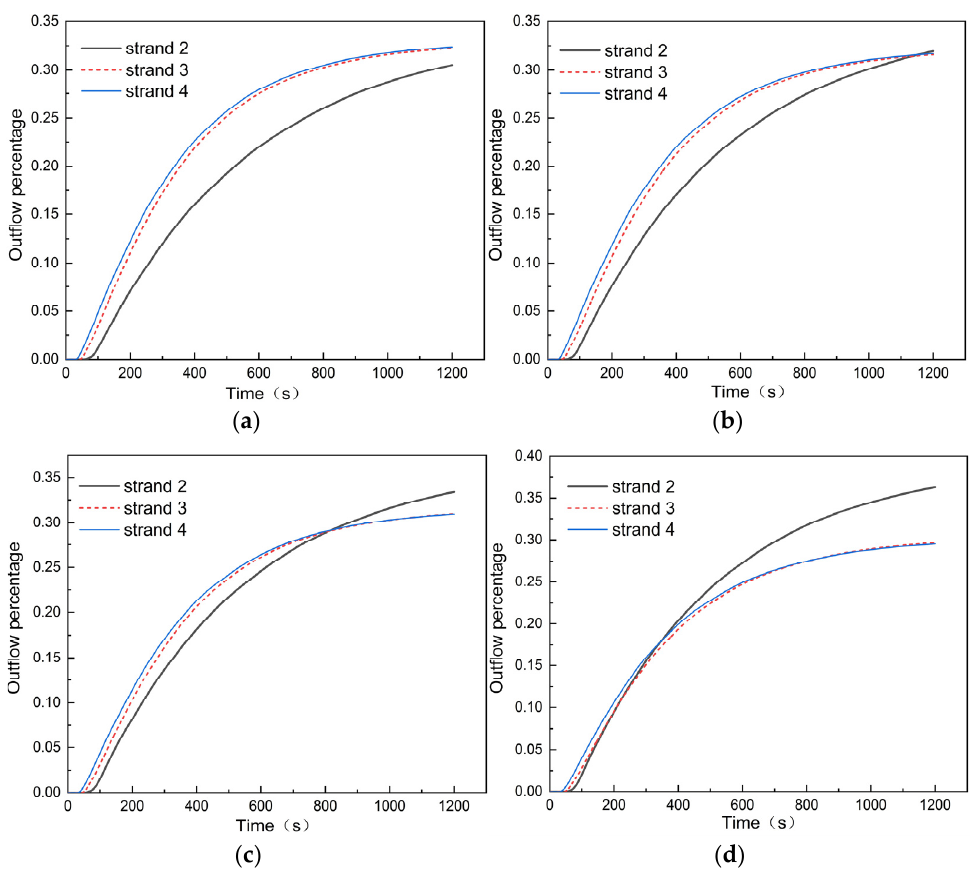
Figure 22. Outflow percentage curve of the double-weir tundish with non-uniform increasing casting flow rate under strand 1 blockage conditions: ( a ) 1.4 q,1.3 q, 1.3 q, ( b ) 1.45 q, 1.275 q, 1.275 q, ( c ) 1.5 q, 1.25 q, 1.25 q, ( d ) 1.6 q, 1.2 q, 1.2